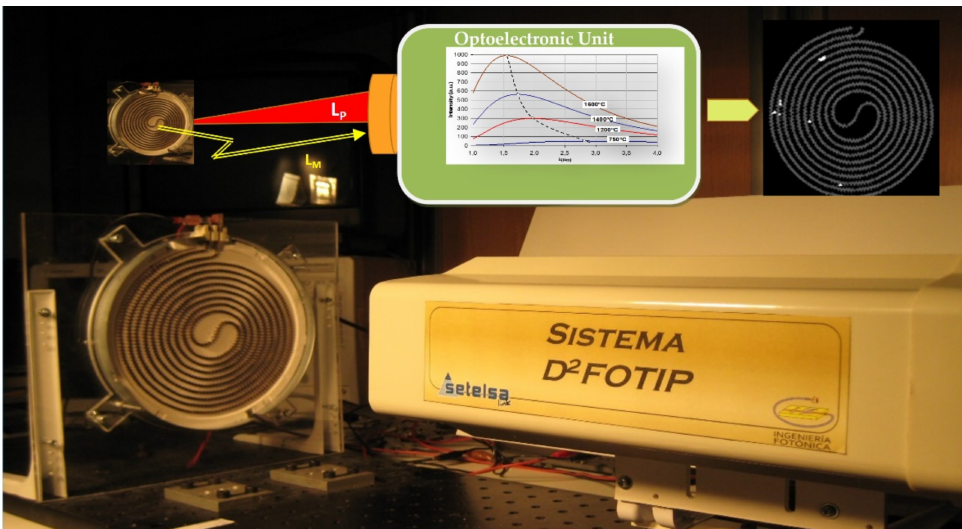
Figure 12. Illustration of SPA-IRT sensor device for online quality control of radiant heaters. After a short energy pulse, the infrared radiations of the cooling process of the heaters were captured and properly treated/processed with adequate algorithms; images with detected defects were synthesized and the OU’s output offered actuation signals. Made by the author based on material courtesy of Photonics Engineering Group of the University of Cantabria,